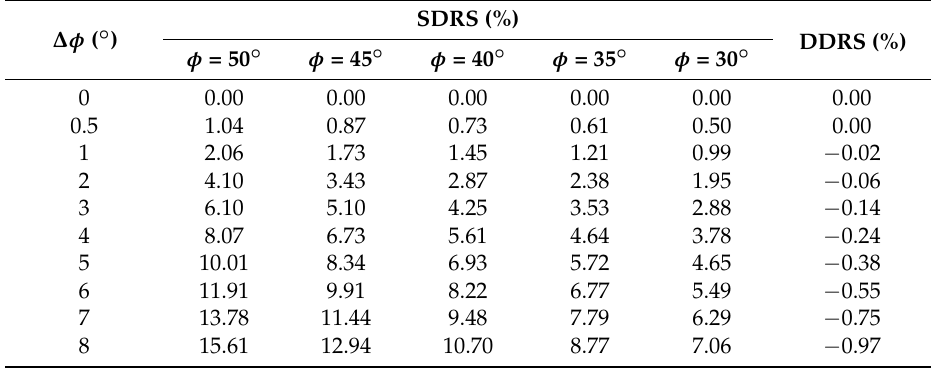
Figure 6. Absolute values of relative measurement errors of the SDRS and the DDRS in the actual situation with different installation deviation angles. Table 1. Relative measurement errors of the SDRS and the DDRS in the actual situation with different installation deviation